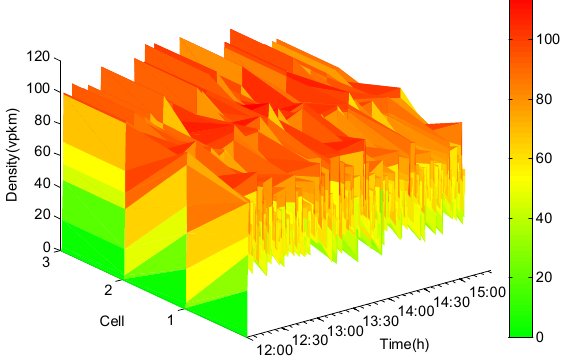
Figure 5. Simulated data for vehicle densities.